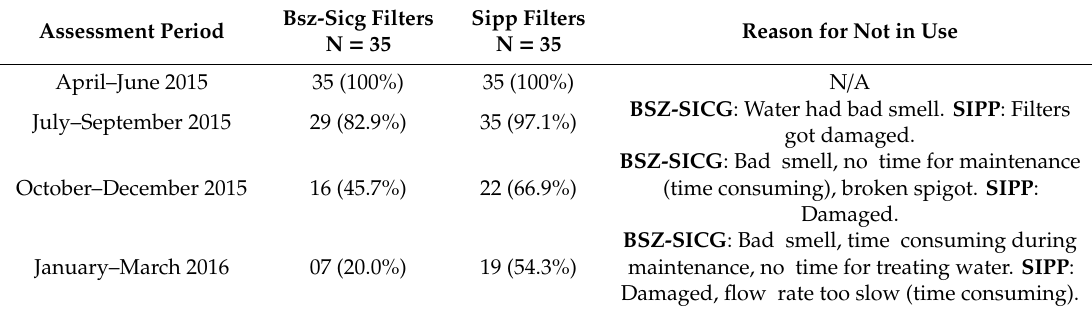
Table 4. Number of household water treatment systems in use throughout the study period and the reasons for not being in use.